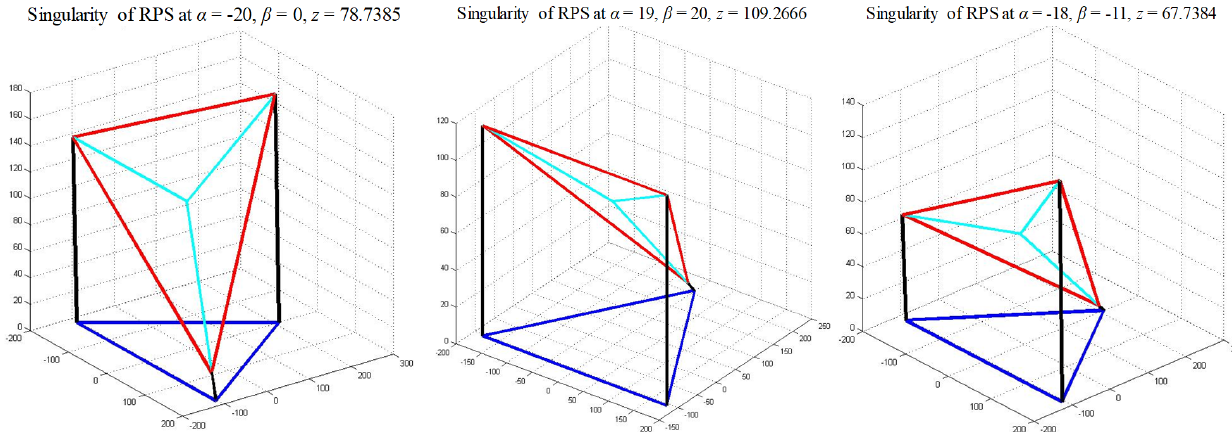
Figure 6. Three examples of singular configurations for the 3-RPS mechanism.